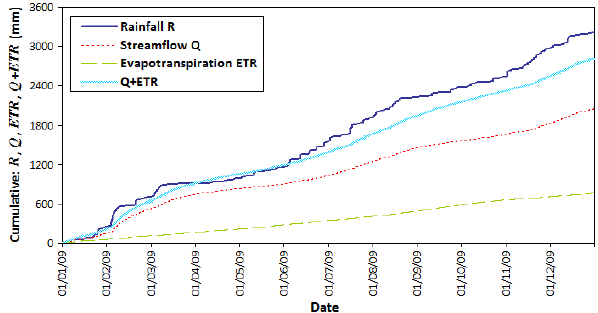
Fig. 6. Water balance in the experimental basin for 2009. Only measured values are presented